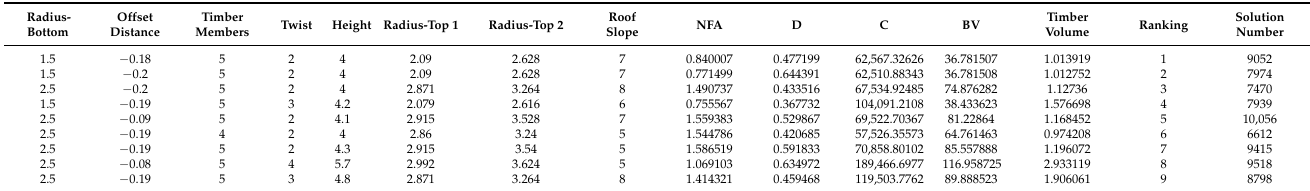
Table 4. Nine best design solutions, attributes, and objectives .